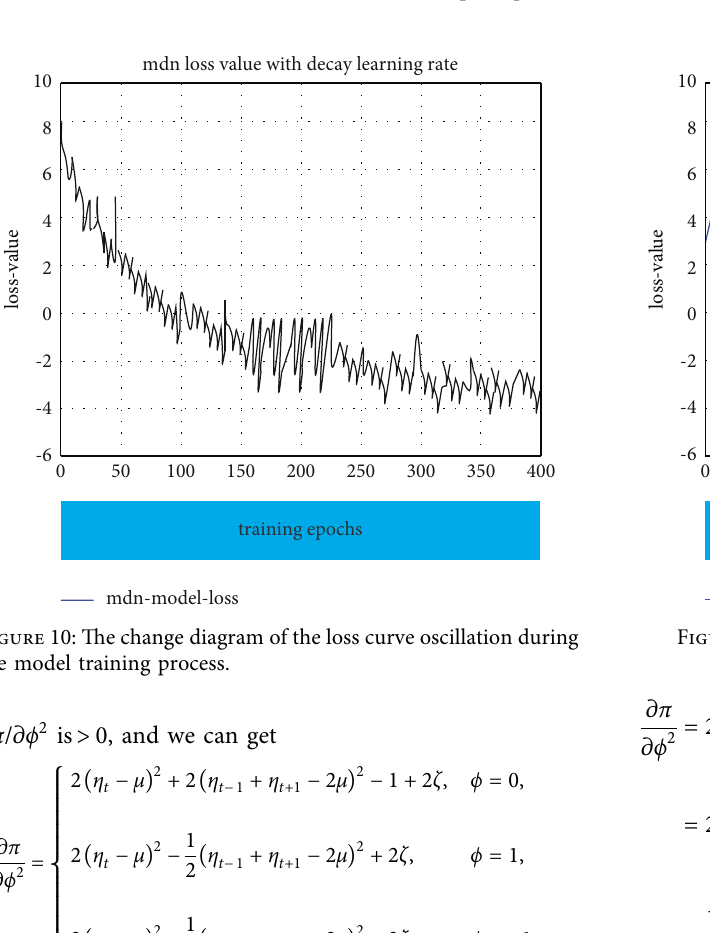
Figure 9: The principle of the time sliding window method.